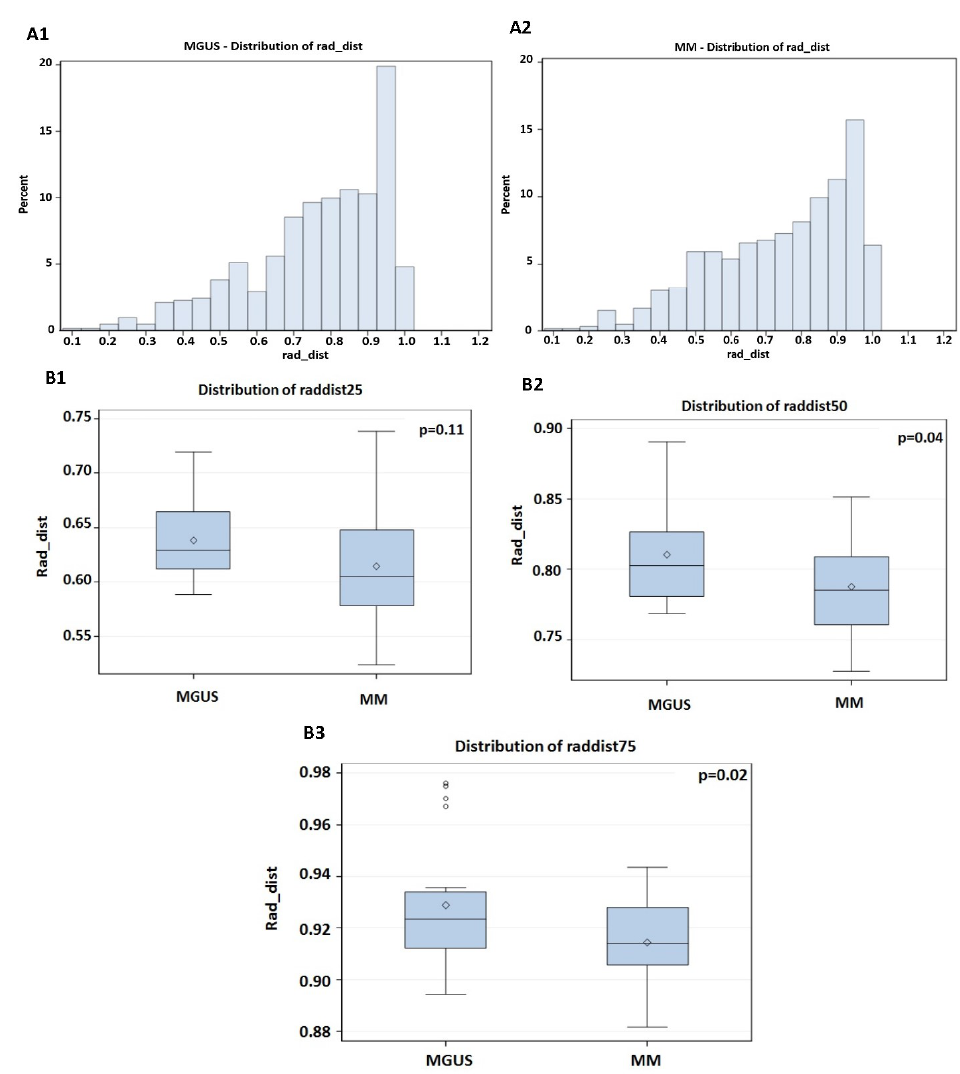
Figure 5. Histograms of the centromeric frequency distributions along a radial nuclear axis starting from the nuclear center (0) to the nuclear periphery (1.0) for all MGUS and MM patient groups ( A1 and A2 ). In B1 – B3 , the di ff erences in centromeric distribution frequencies are represented. Centromeric signals are divided into four quartiles by groups MGUS and MM. The rad_dist are ranked from lowest to highest, and where 25% of the distance from lowest is named raddist25 (the q1—first quartile) (close to the nucleus) ( B1 ), where 50% (half) is named raddist50 (this is also referred to as the median—midpoint between the nuclear center and the nuclear periphery) ( B2 ), and where 75% is named raddist75 (third quartile) (close to the periphery of the cell) ( B3 ). Centromeres in cells from MGUS patients displayed a significantly greater distribution in both subdivisions (midpoint between the nuclear center and the nuclear periphery and close to the periphery of the cell) of this region than in those from MM patients, indicating that the centromeres are more distributed toward the nuclear periphery than the nuclear center in MGUS than in MM. The p -values for the comparison between MGUS and MM are included in each